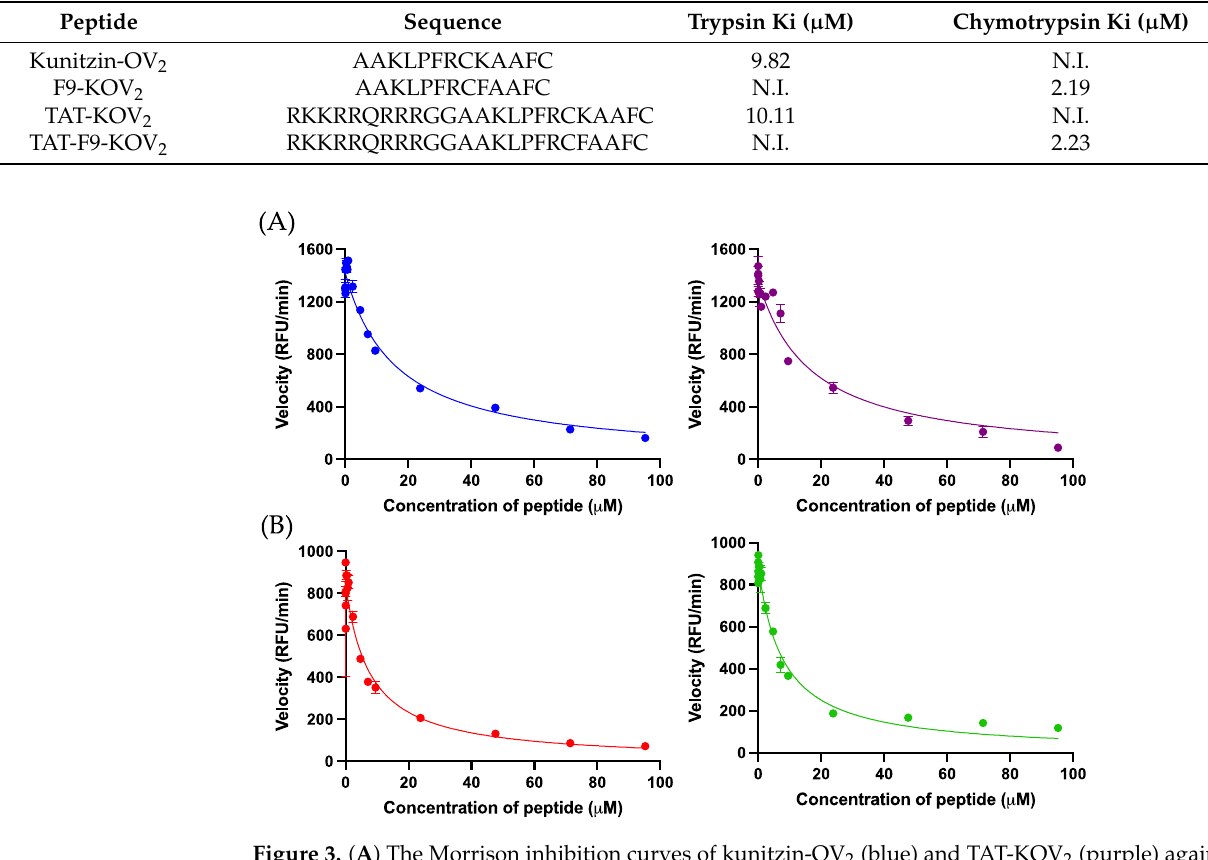
Figure 3. ( A ) The Morrison inhibition curves of kunitzin-OV 2 (blue) and TAT-KOV 2 (purple) against trypsin. ( B ) The Morrison inhibition curves of F9-KOV 2 (red) and TAT-F9-KOV 2 (green) against chymotrypsin. The X-axis represents peptide concentrations and the Y-axis represents the velocity of the fluorescence decay. The Ki values were calculated by Morrison formula in Prism 9, in which trypsin Km = 67.38 µ M, chymotrypsin Km = 17.15 µ M, [S] = 42.86 µ M, Et = 0.0020 µ M. The error bar represents the SEM of nine replications in three